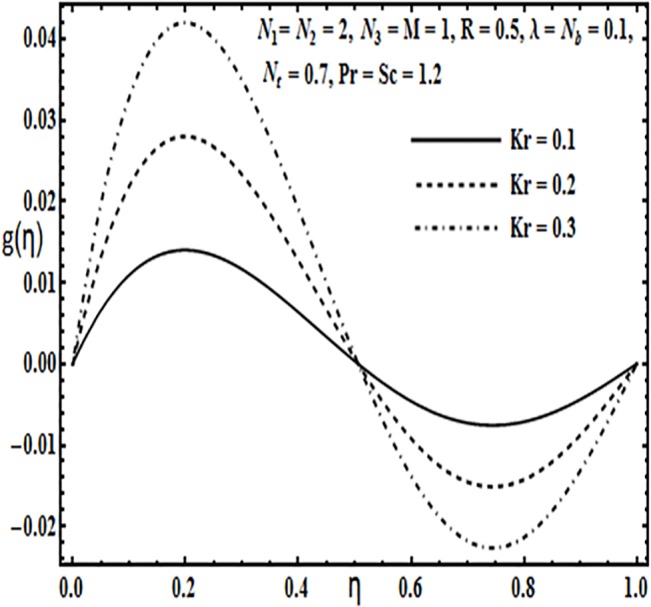
Effect of Kr on g(η).